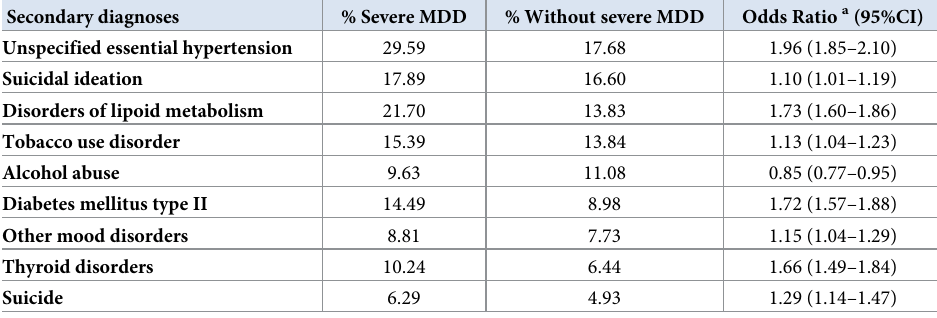
Table 2. Secondary diagnoses found in more than 5% of all patients admitted with or without severe MDD.